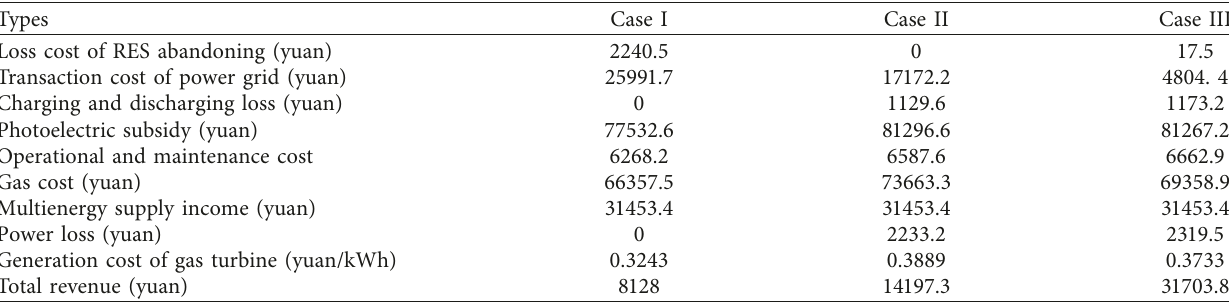
Table 3: Economic statistics of three